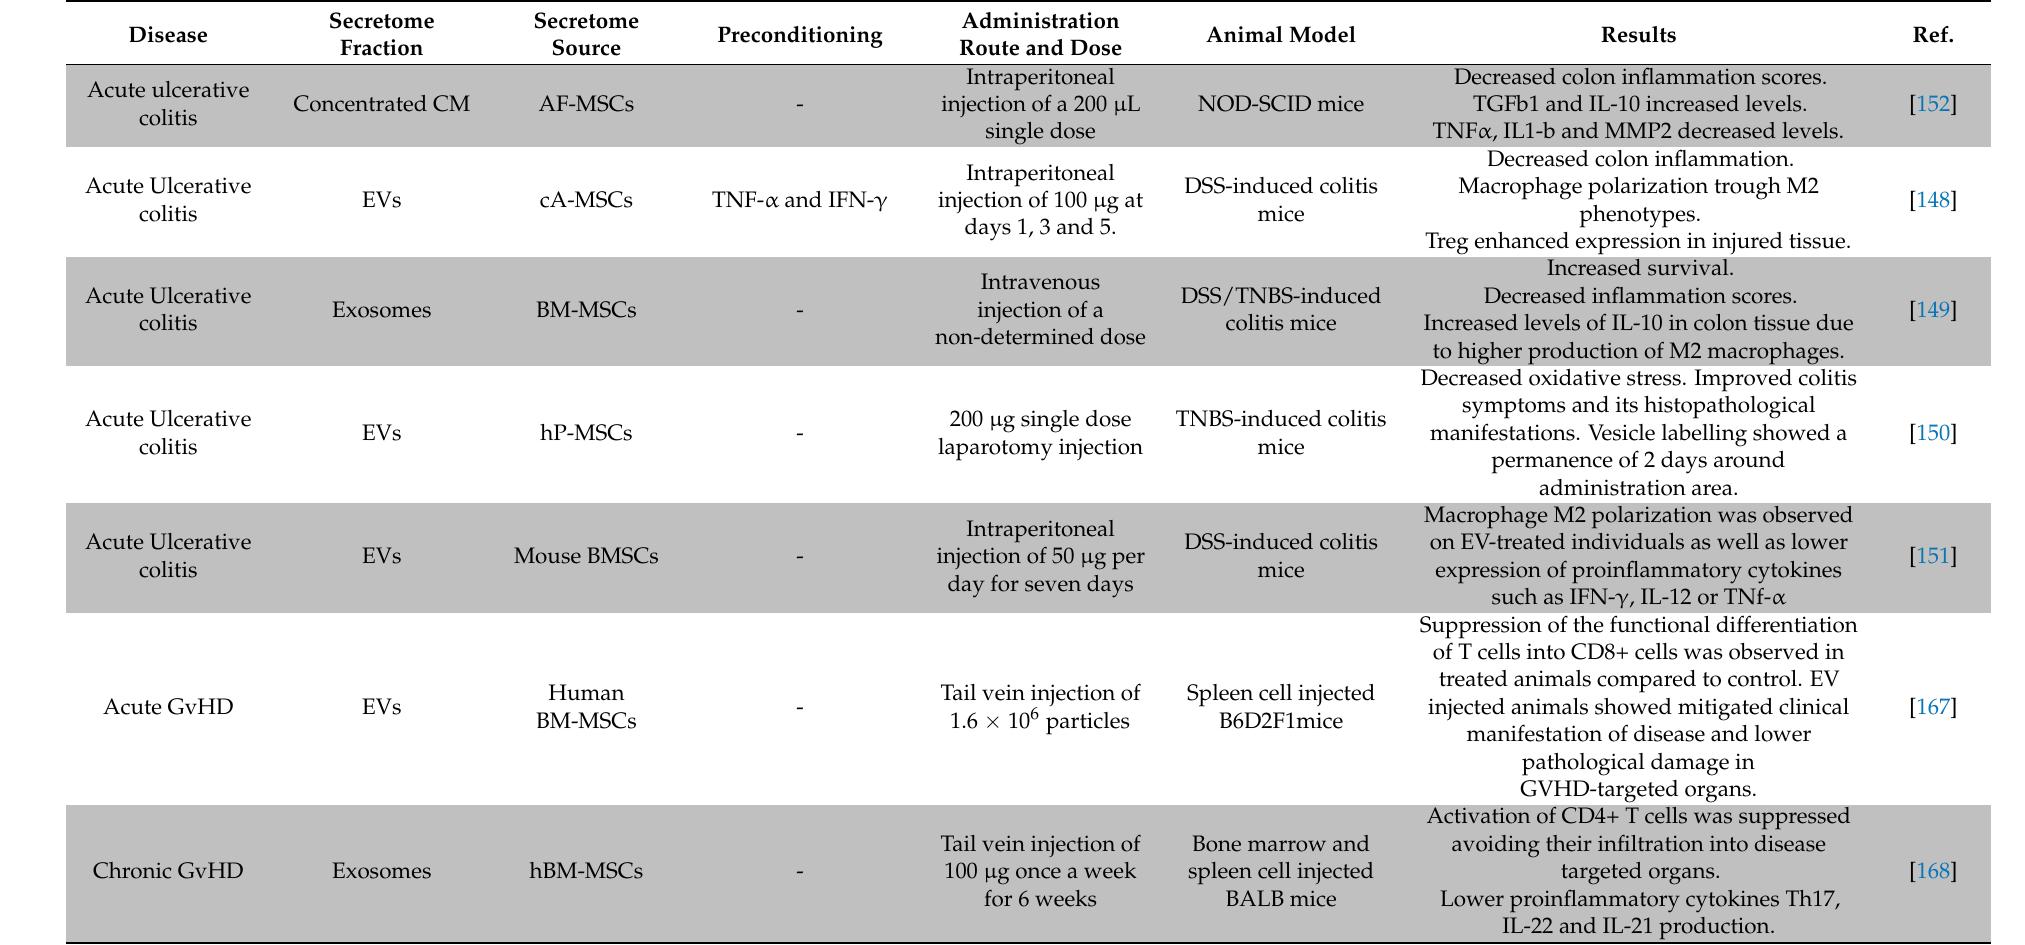
Table 1. Preclinical studies involving secretome application on inflammatory bowel disease (IBD), osteoarthritis (OA) and graft-versus-host disease (GvHD) animal